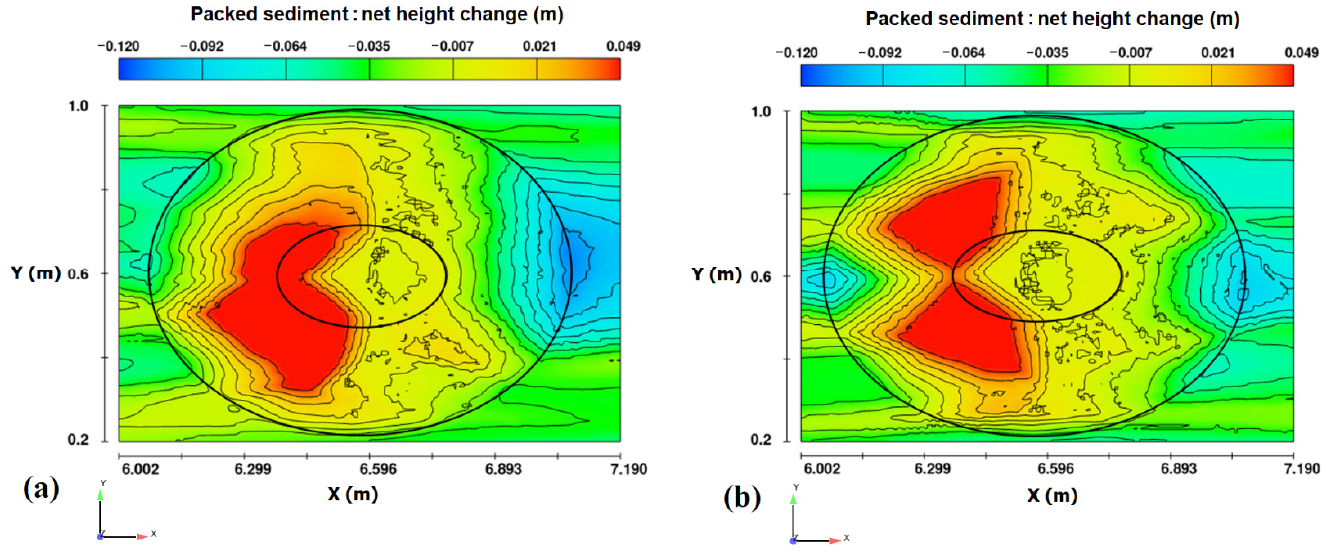
Figure 11. Changes in the harvest pit in the plane (plane x–y): ( a ) circular model, ( b ) hydrodynamic model.